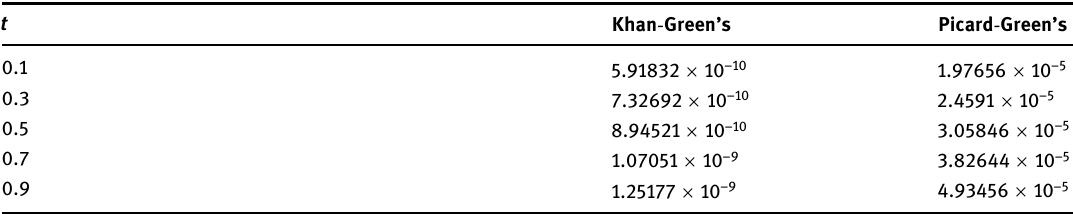
Table 3: Relative absolute errors of Example 1